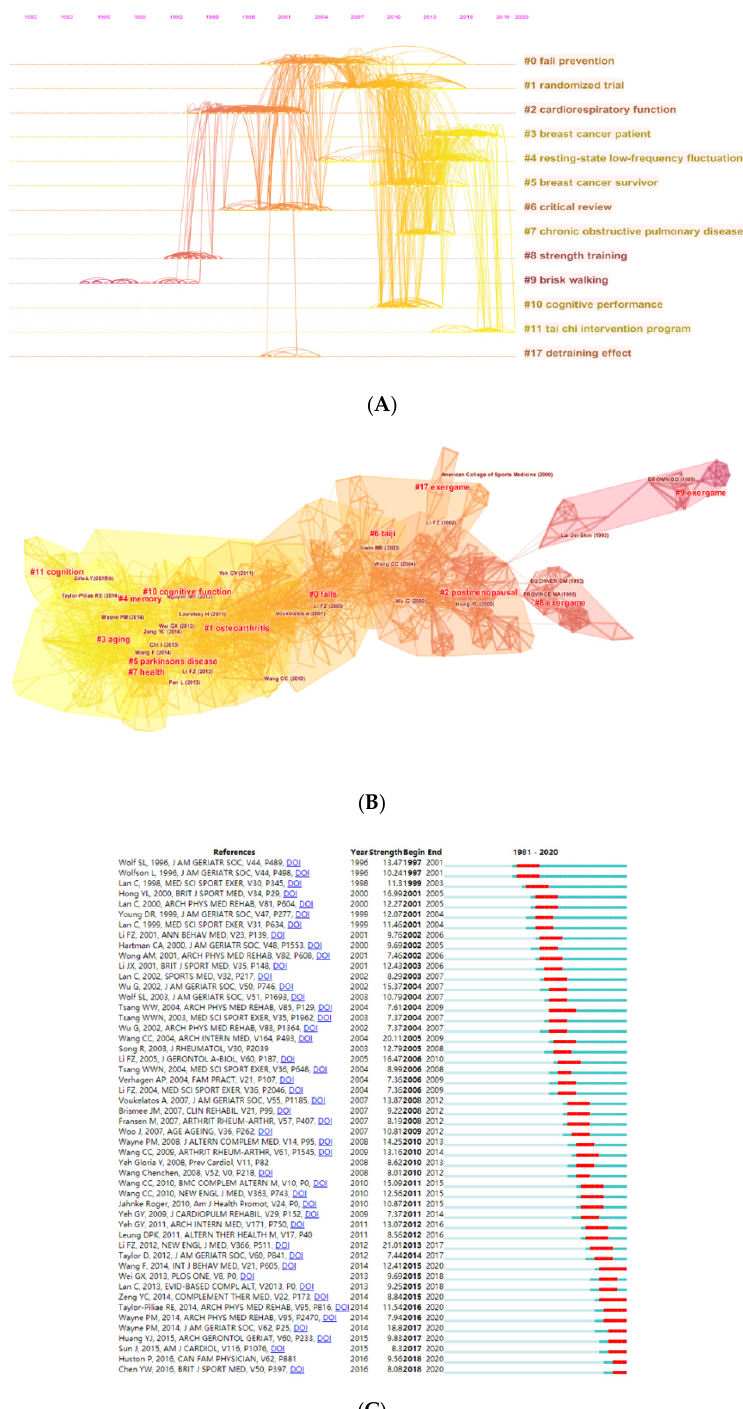
Figure 4. ( A ) Map of timeline view based on the reference co-citation analysis in the field of Tai Chi research; ( B ) Map of cluster view based on the reference co-citation analysis in the field of Tai Chi research; ( C ) Map of the top 50 burst references based on the reference co-citation analysis in the field of Tai Chi research.